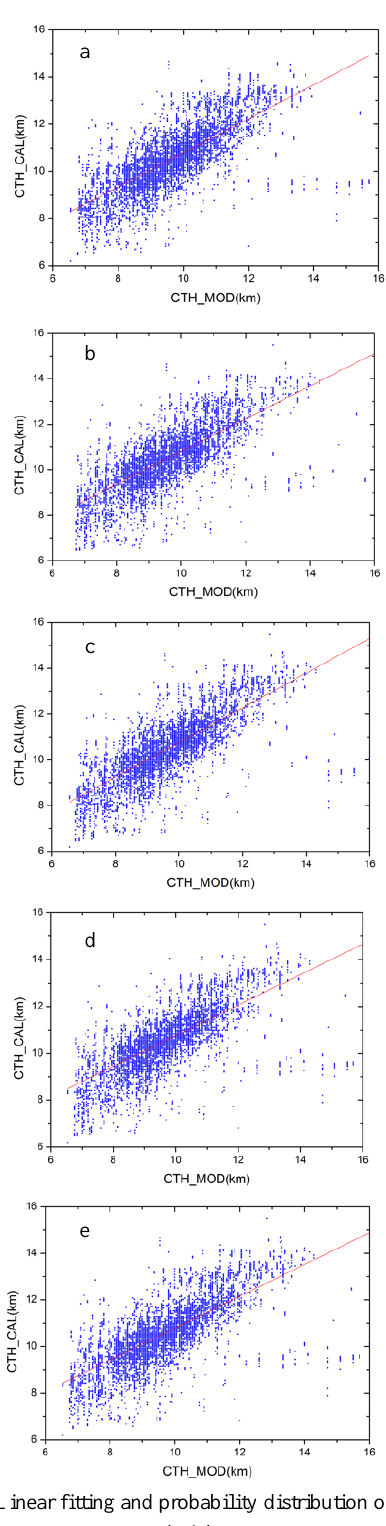
Figure 2. Linear fitting and probability distribution of cloud top height (x and y axis in the five panels above represent cloud top height of MODIS and CALIPSO, with unit of km. The panels from top to bottom represent fitting results from every four years out of